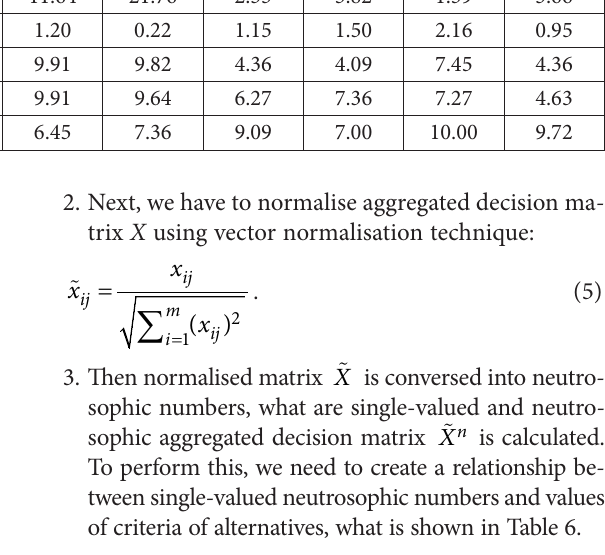
Table 6. Crisp to neutrosophic conversion expressions describing the criteria of the alternatives